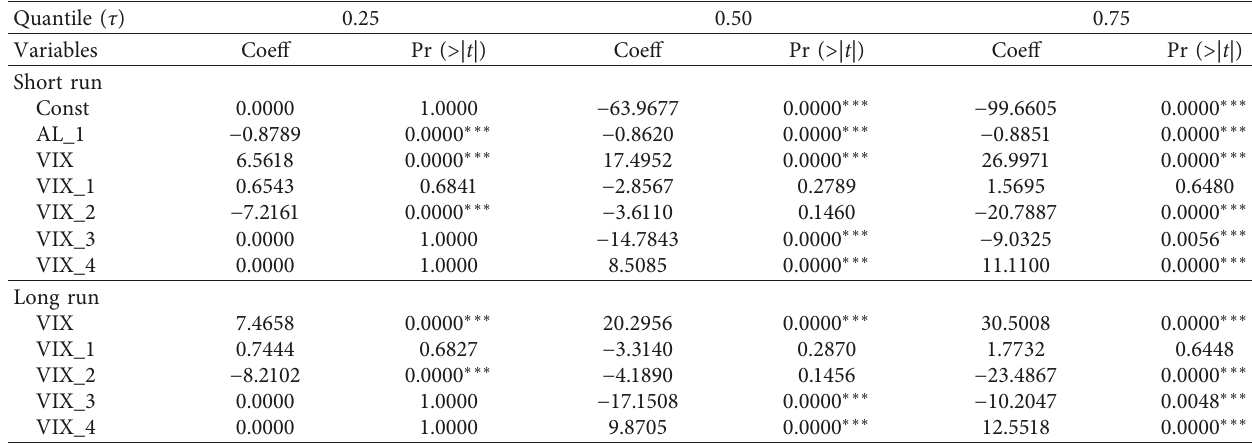
Table 10: QARDL estimation results: pandemic period (independent variable: VIX).